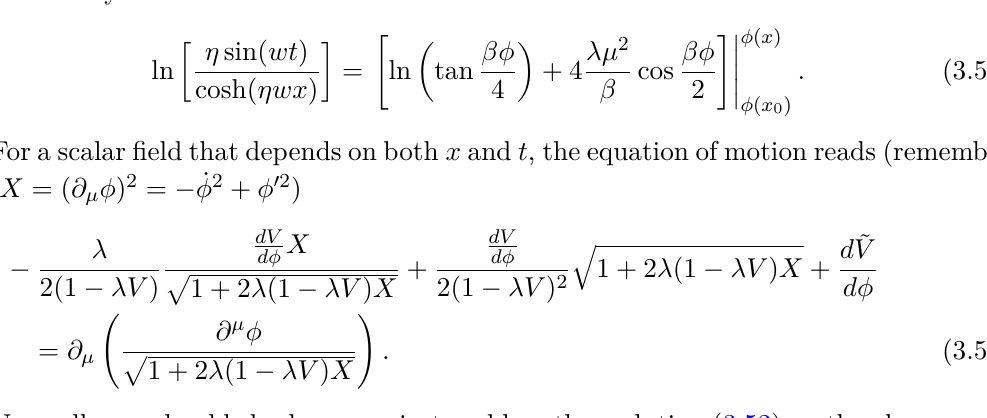
Figure 6 . The profile of the modified Higgs-like soliton. a a = 1 and λα =0.1, 0.5, 1 in brown, purple and blue,